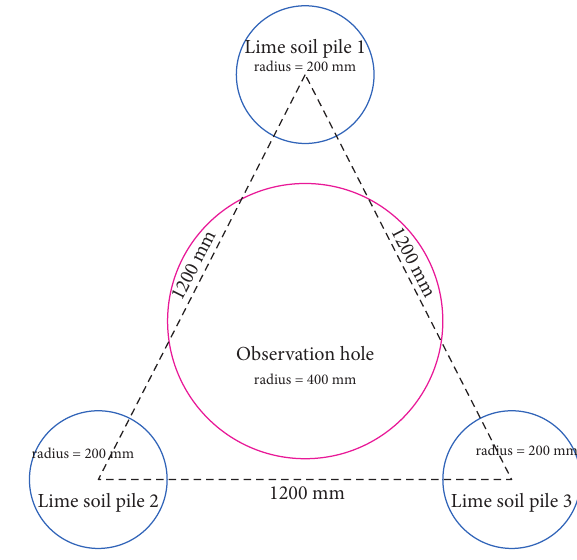
Figure 2: Schematic diagram of the test model.